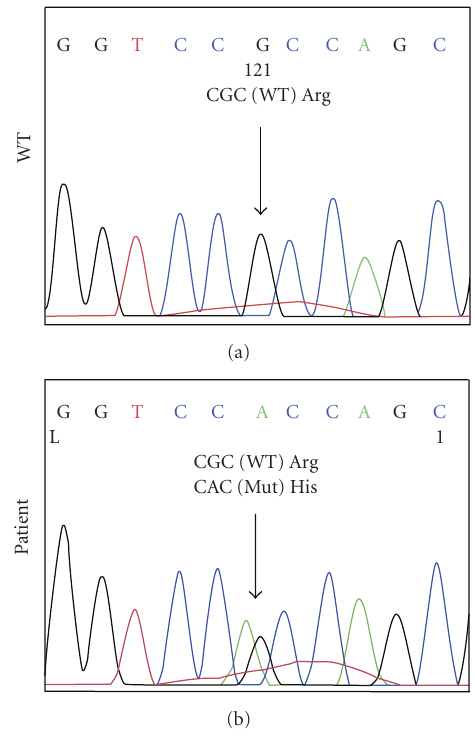
Figure 1: Sequence analysis demonstrated a C to A transition in the patient. This change substitutes histidine for arginine at residue 31 in the paired domain denoted by the arrow. WT: